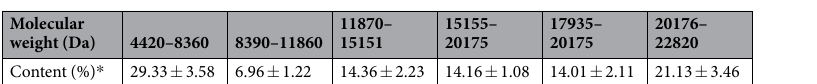
Molecular weight (Da)